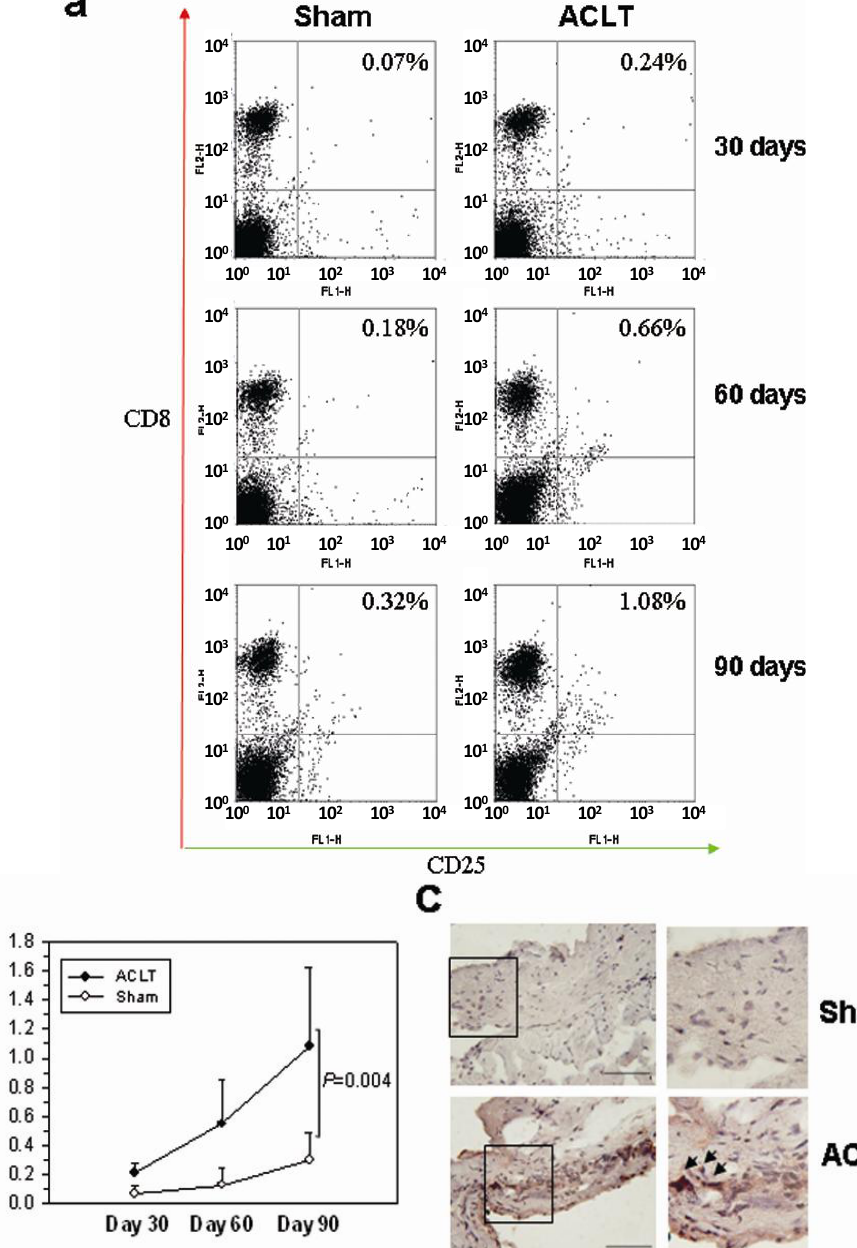
Figure 2. Quantitation of CD8 + T cells in mice with OA. ( a ) Splenocytes of four mice per group were stained for surface CD8 and CD25 on day 30, 60 and 90. Data are expressed as the percentage of CD8 + /CD25 + T cells/1 × 10 6 splenocytes. Representative flow cytometry data from each group are shown; ( b ) The number of activated CD8 + T cells in the ACLT group increased remarkably during the progression of OA. Data are as means ± 95% confidence intervals. Significant difference was showed 90 days after ACLT ( p = 0.004); and ( c ) Synovial membranes from Sham- and ACLT-group mice on day 90 were removed and stained with antibody against CD8. The infiltrated CD8 + T cells were indicated with arrows. Representative sections of synovium in each group are shown [Immunohistochemistry (IHC) stain; 200× magnification; scale bar = 200 µm; the inset represents the magnified area; ×400 magnification].